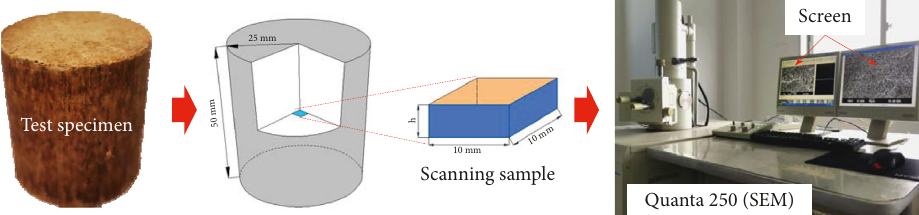
Figure 9: Fabrication of a specimen for electron microscope scanning and actual image in the experiment.